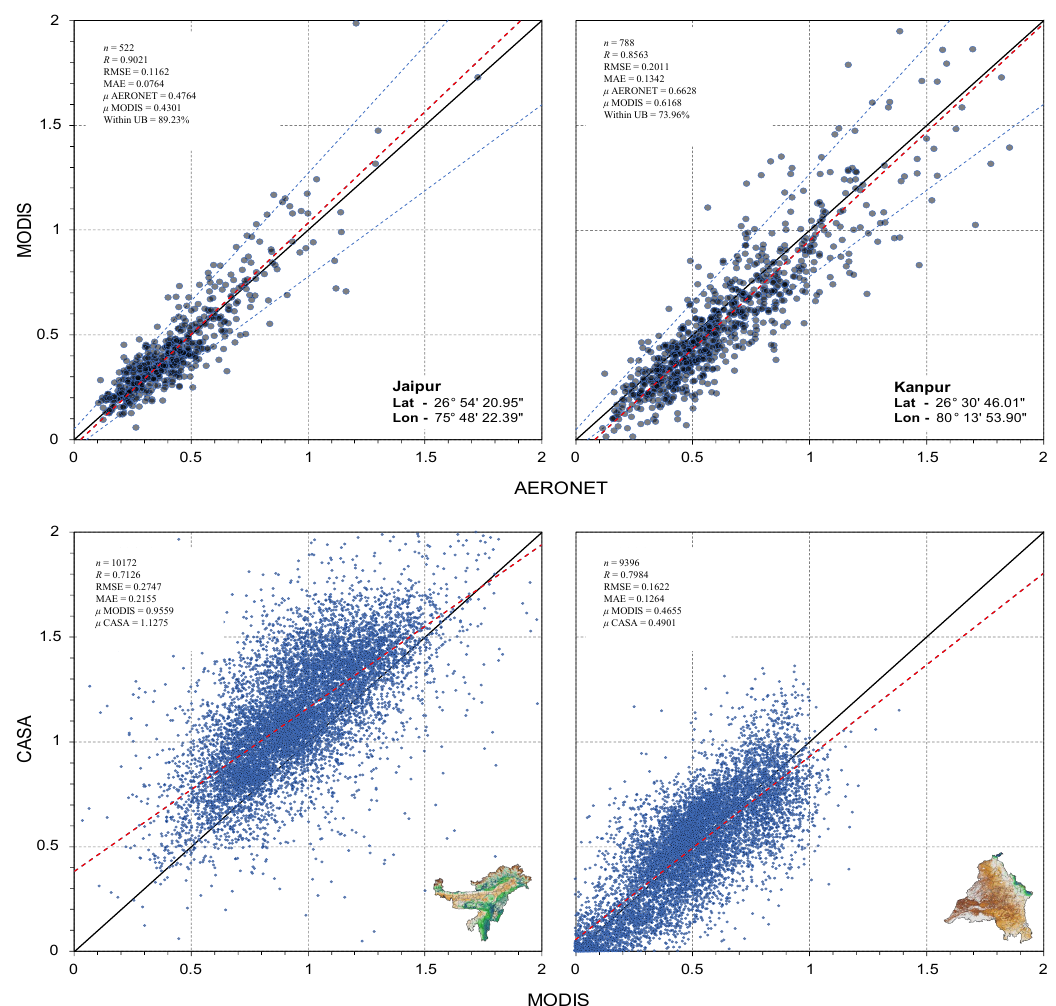
Figure 1. Scatter plots represent the validation of AOD and NPP. The upper panel compares AOD MODIS against AOD AERONET for two sites with a data record for 2017–2019. The blue dash repre- sents the uncertainty bounds (UB). The lower panel highlights the comparison between NPP CASA and NPP MODIS aggregated for 2019 for the spatial bounds of EH and TGP. The solid black line epitomizes 1:1 agreement, and the linear trend fit is red